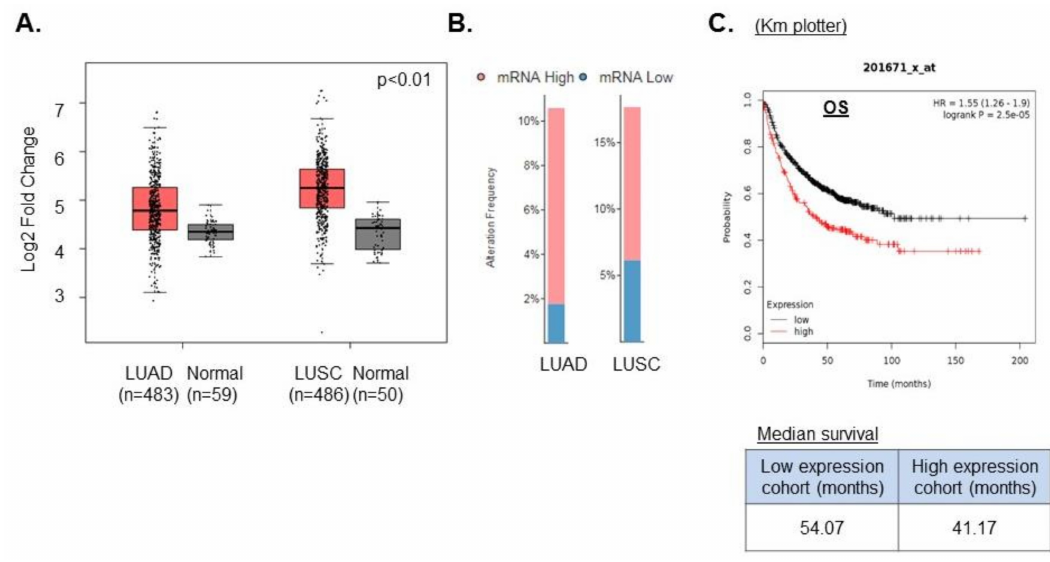
Figure 1. High USP14 expression correlates with poor prognosis in non-small cell lung cancer (NSCLC). ( A ) Di ff erential USP14 mRNA expression analysis in lung adenocarcinoma (LUAD) vs. normal lung and lung squamous cell carcinoma (LUSC) compared to normal lung using the Gene Expression Profiling Interactive Analysis (GEPIA) database. ( B ) USP14 mRNA expression analysis in LUAD and LUSC using TCGA. ( C ) KM Plotter data for overall survival (OS) in low or high USP14-expressing LUAD